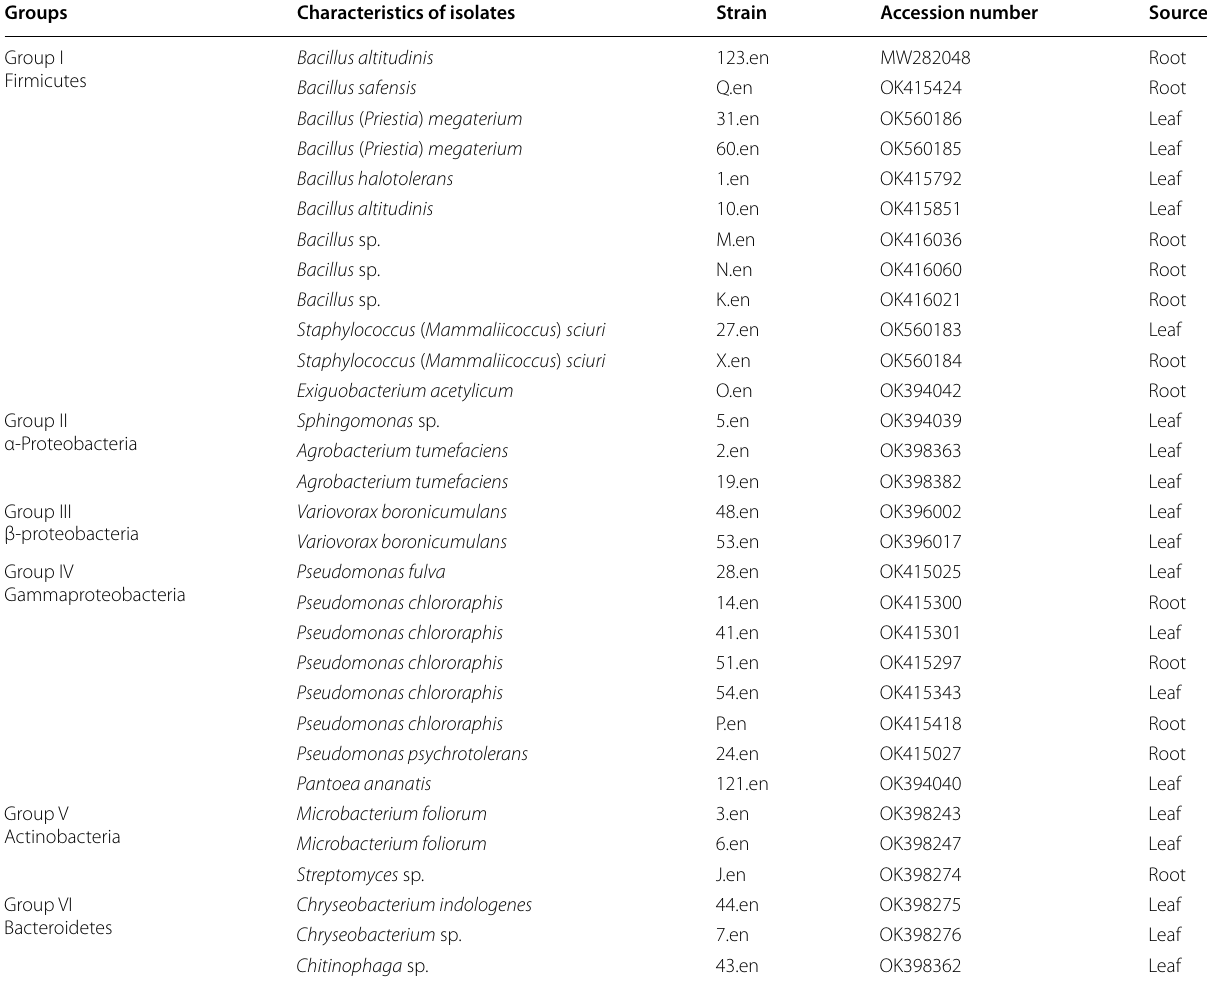
Table 1 Identification of isolated endophytic bacteria from kiwifruit